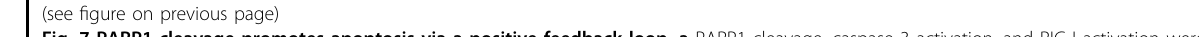
Fig. 7 PARP1 cleavage promotes apoptosis via a positive feedback loop. a PARP1 cleavage, caspase 3 activation, and RIG-I activation were examined in wild-type U2OS cells and U2OS cells expressing non-cleavable PARP1 (D214N) at different time points during 5 μ g/mL poly(dA-dT)- induced apoptosis. b Myc-tagged POLR3B, POLR3F, or POLR3G subunit was expressed in U2OS cells. ADP-ribosylation of Pol III was examined by IP and western blotting with the indicated antibodies in a time course in cells treated with 5 μ g/mL poly(dA-dT). c Induction of IFN- β by poly(dA-dT) was analyzed by luciferase reporter assay in wild-type or PARP1-null cells. d Induction of IFN- β by poly(dA-dT) was examined in U2OS cells with or without 1-h treatment with 1 µM olaparib. e Induction of IFN- β by poly(dA-dT) was determined in PARP1-null cells reconstructed with wild-type PARP1 or the D214N mutant. f Apoptotic cells were examined by Annexin V-FITC/PI double staining in parental U2OS cells or PARP1 knockout cells. g Apoptotic cells were examined by Annexin V-FITC/PI double staining in U2OS cells with or without 1-h treatment with 1 µM olaparib. h Apoptotic cells were examined by Annexin V-FITC/PI double staining in the PARP1-null cells reconstructed with wild-type PARP1 or the D214N mutant. Note that the apoptotic cells were harvested after 6-h treatment with 5 μ g/mL poly(dA-dT) in c – h . Data are represented as means ± SD as indicated from three independent experiments. Signi fi cance of differences was evaluated by Student ’ s t -test. * P < 0.05; ** P < 0.01; *** P <